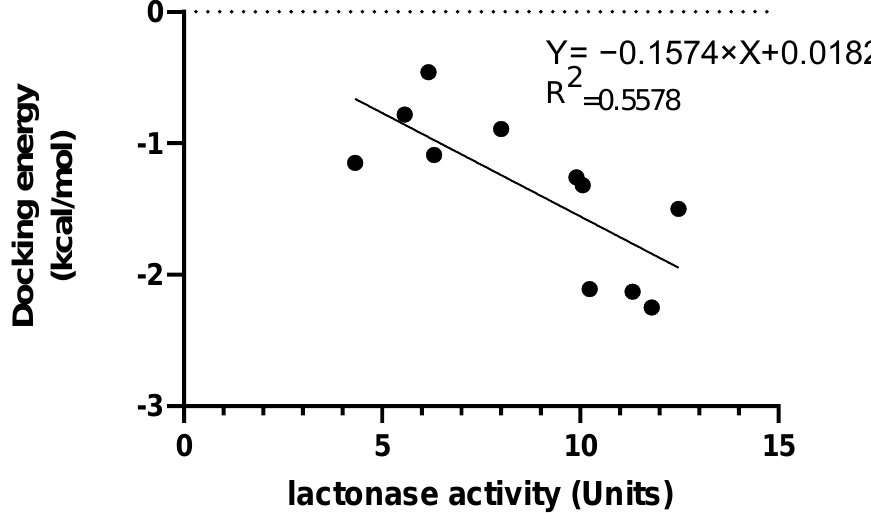
Figure 6. Correlation between the binding energy calculated from the AutoDock Tools program (Y-axis) and the rate at which PON1 catalyzes lactone hydrolysis (X-axis). The anticipated inverse correlation was obtained, with R 2 = 0.5578 ( p < 0.05).